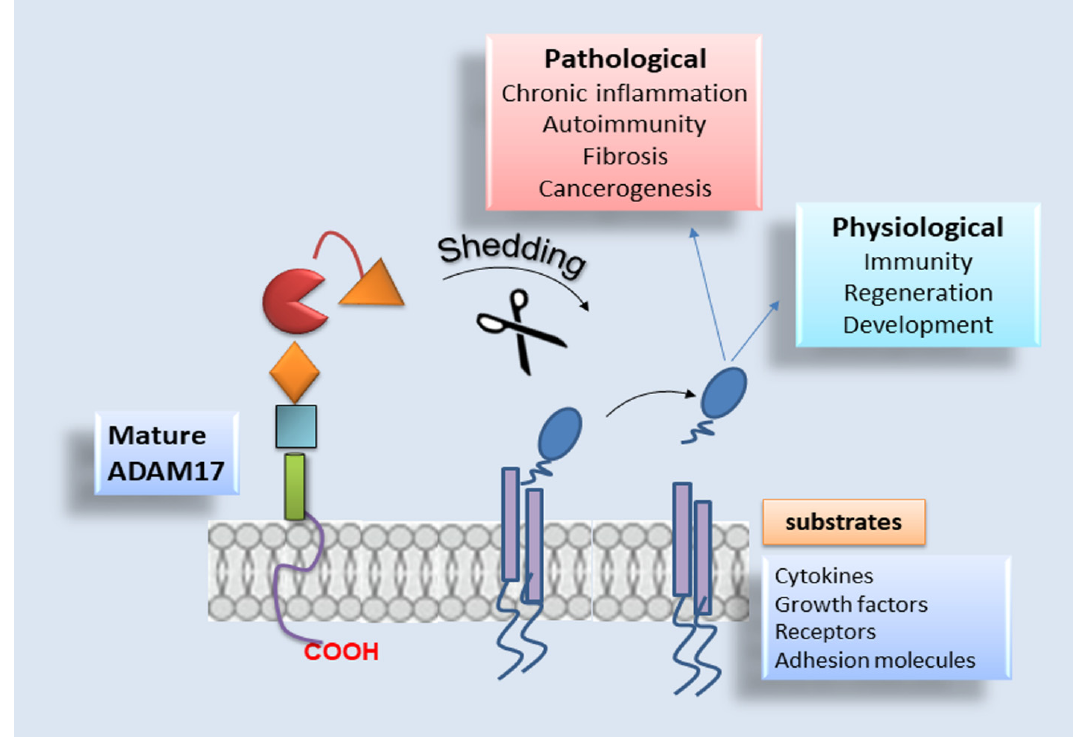
Figure 2. The sheddase ADAM17: schematic representation. ADAM17 sheds 80 several substrates, acting in multiple physiological processes, such as immunity regeneration and development. By contrast, the enzyme acts in various pathological conditions, such as autoimmune diseases, chronic inflammation followed by fibrosis and cancer progression.